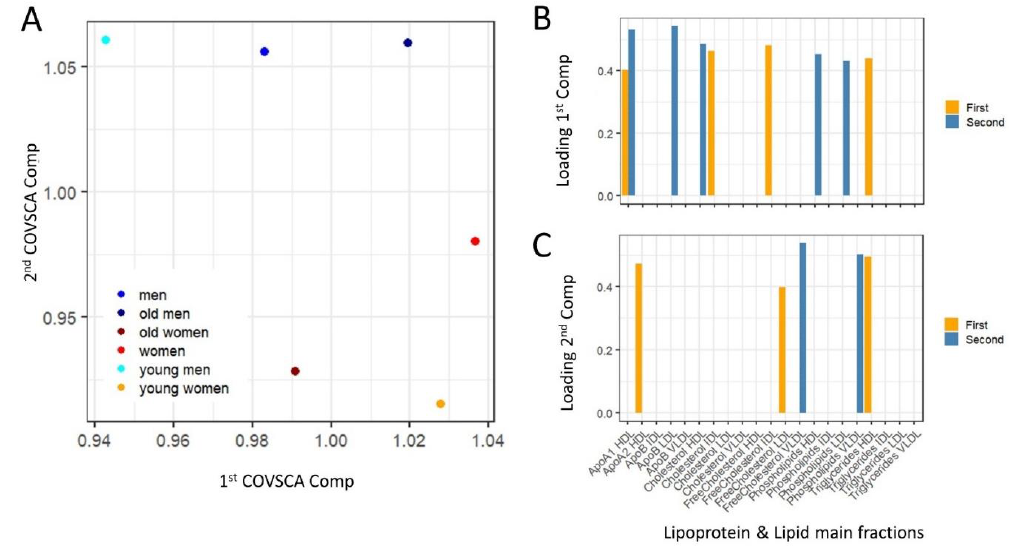
Figure 5. Covariance Simultaneous Component Analysis of the lipoprotein and lipid fractions association networks for all male subjects (men), all female subjects (women) and young/old men and young/old women. ( A ) COVSCA score plot: each dot is a low-dimensional representation of lipid association network. ( B , C ) Loadings associated with the two COVSCA components: since the COVSCA model is fitted with two rank-2 prototype matrices there are two sets of loadings for each component (see Equation (6)). The loadings describe the relative importance of each lipoprotein and lipid fraction in describing the different correlation structure observed in the network specific to each sex and age group. Loadings were filtered on the basis of z -score: only loadings with z -score > 1 have been retained.